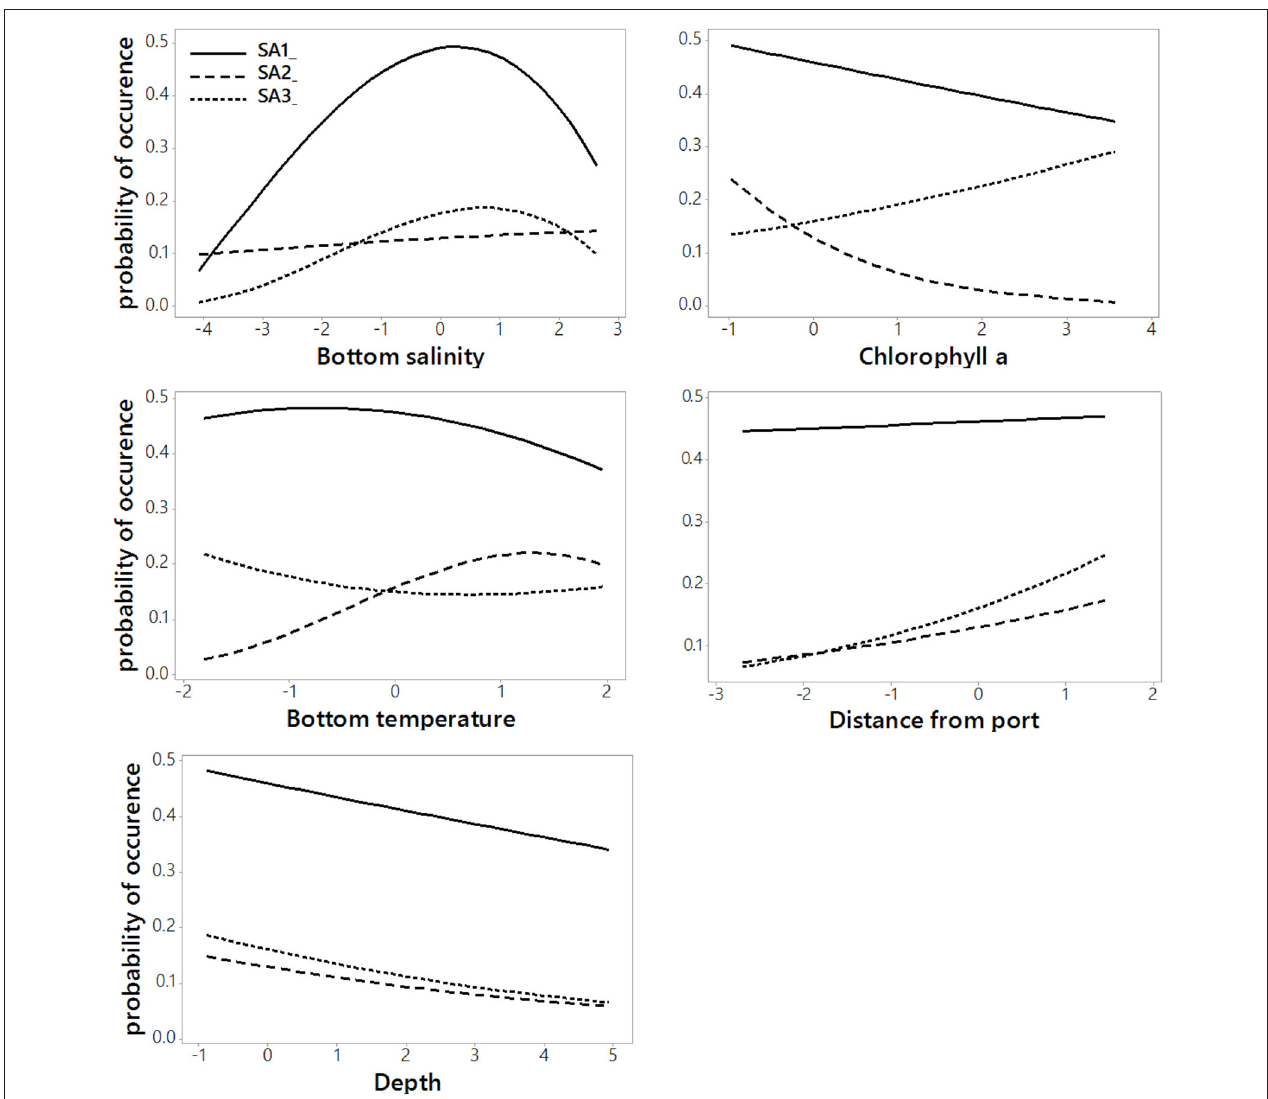
FIGURE 3 | Partial effects plots of Species Archetype responses to each predictor variable when all other variables are held constant at their respective means. Values on the x-axis are standardized to zero mean and unit standard